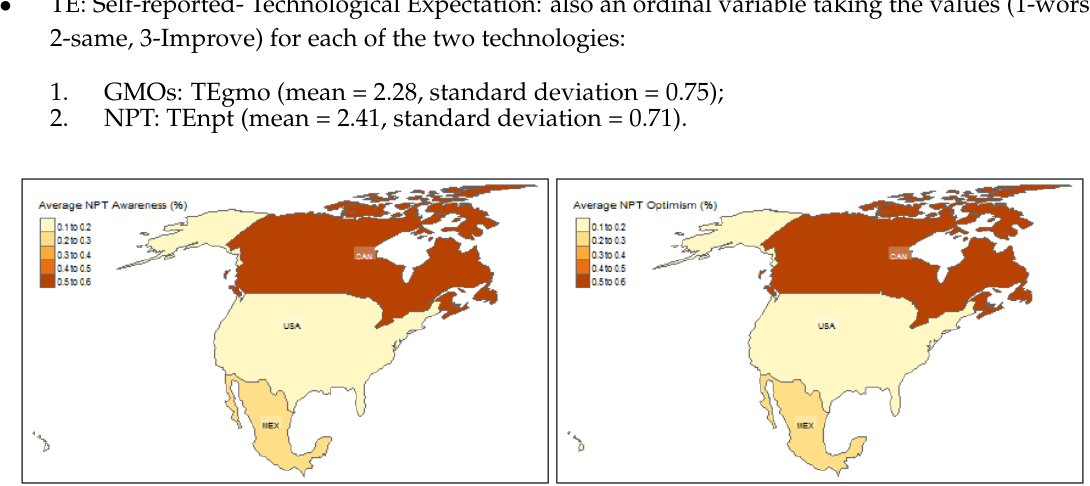
Figure 2. Spatial distribution of youth NPT awareness and expectations within